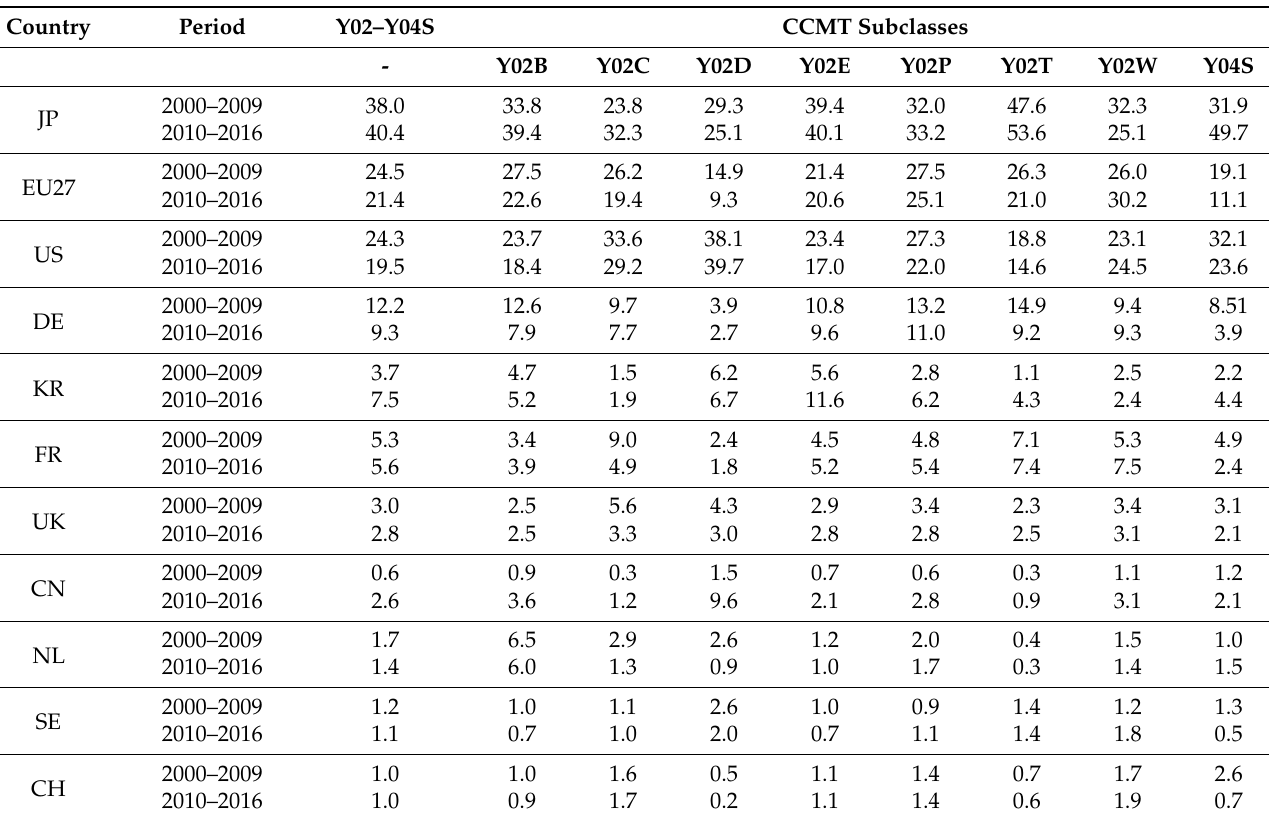
Table 2. Shares in CCMT-TPFs; total and by CPC class (2000–2009, 2010–2016; 5-year MA), (2010–2016 top-10 patenting countries plus